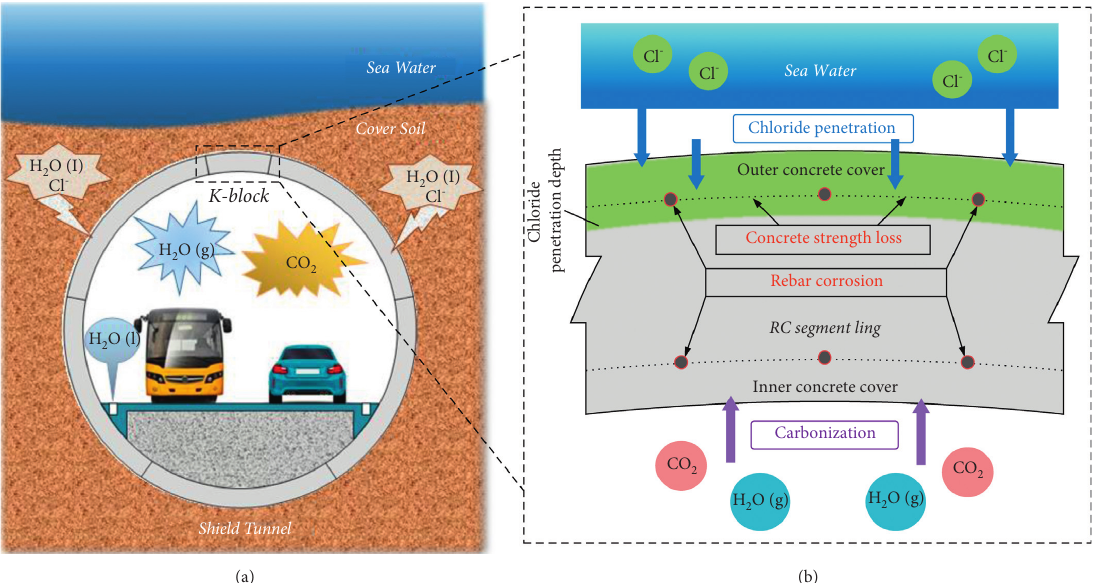
Figure 1: Typical working environment of subsea shield tunnel: (a) shield tunnel lining segments in the subsea corrosive environment and (b) performance degradation mechanism of lining